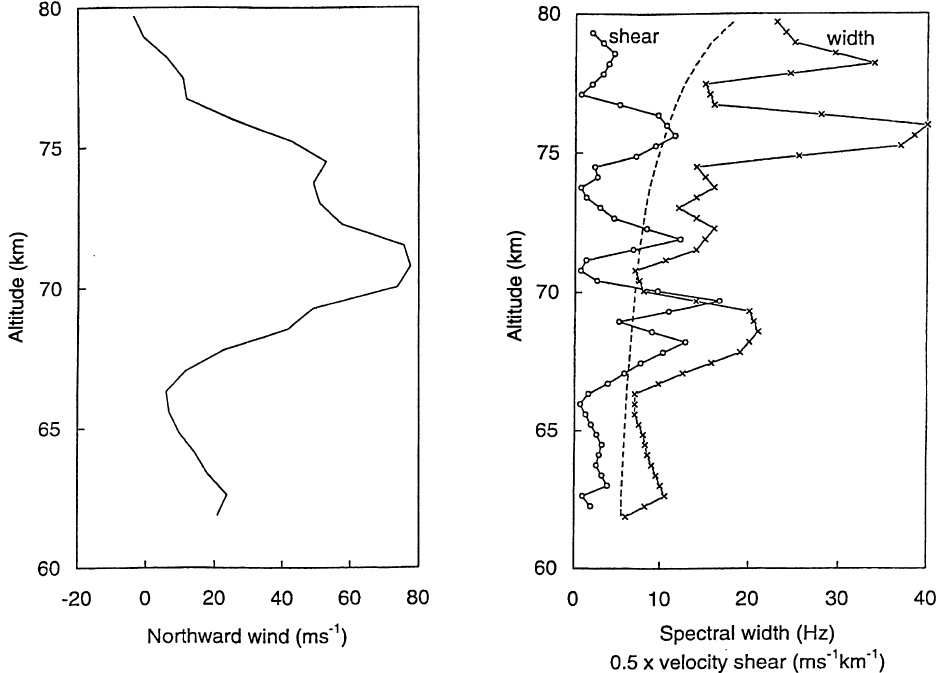
Fig. 10. As Fig. 5, but with an IPP of 6.666 ms. The measurements are from 0905 UT on 21